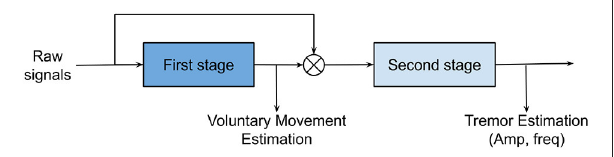
FIGURE 6 | Two-stage tremor modeling. Voluntary motion in the low-frequency bands is estimated in stage 1. Subsequently, stage 2 will characterize tremorous motions (i.e., amplitude and frequencies) after subtracting the voluntary motions from the original